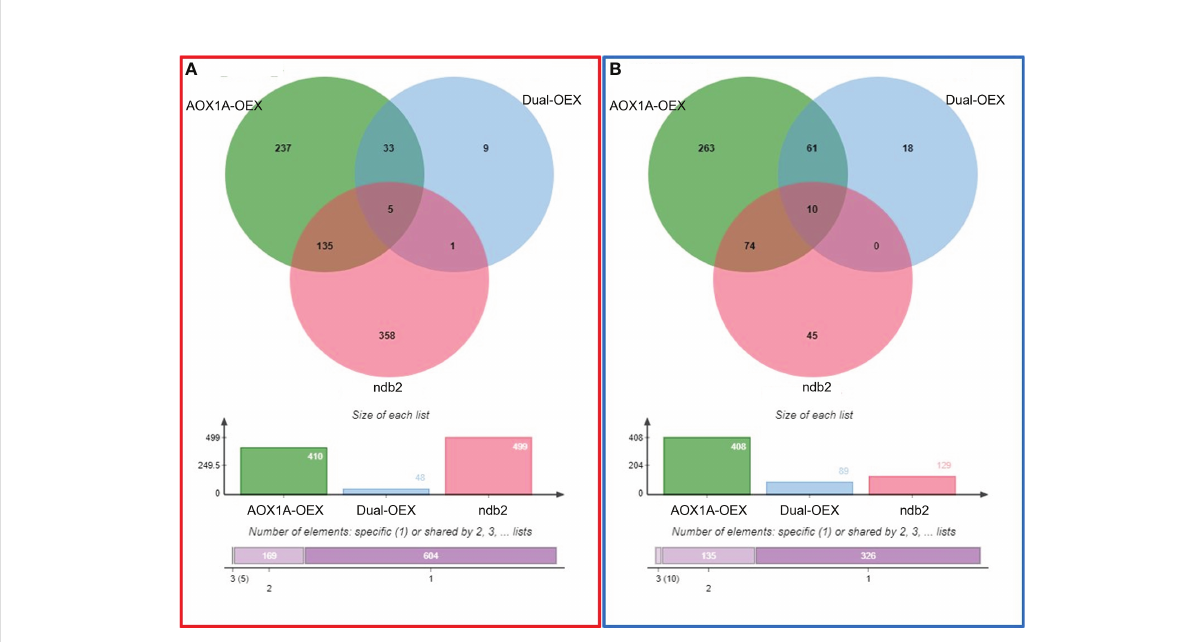
FIGURE 2 Commonalities and differences between (A) up-regulated and (B) down-regulated DEGs, relative to wild type. AOX1A-OEX (green), dual-OEX (blue) and ndb2